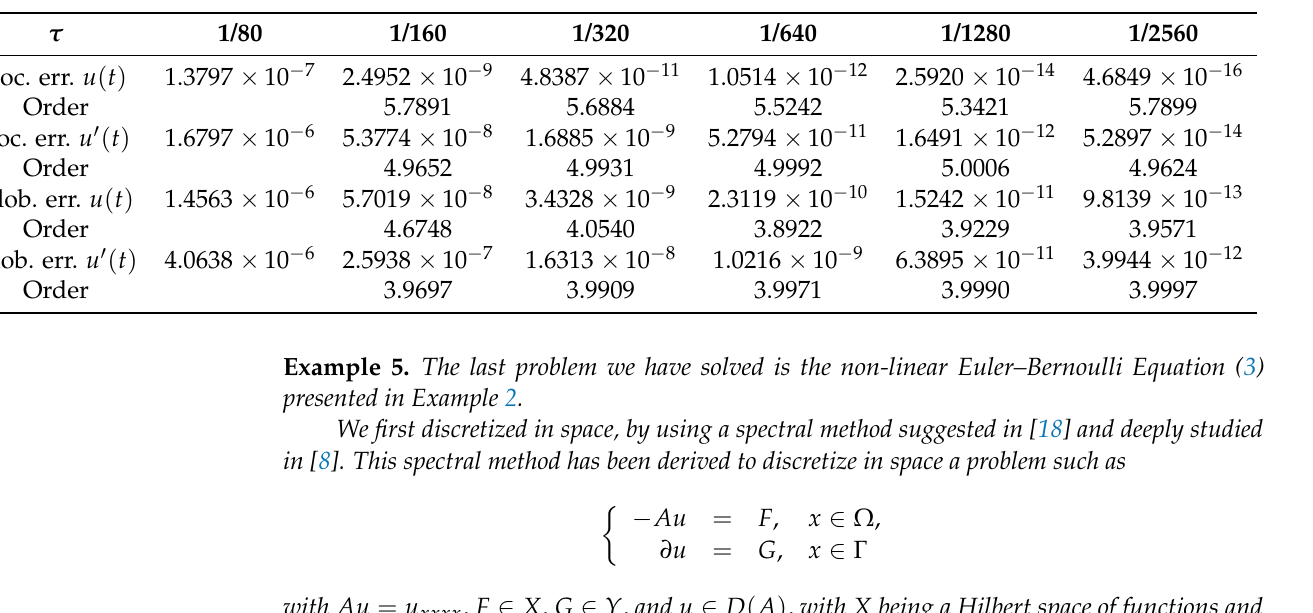
Table 6. Local and global errors and orders for problem (15) with